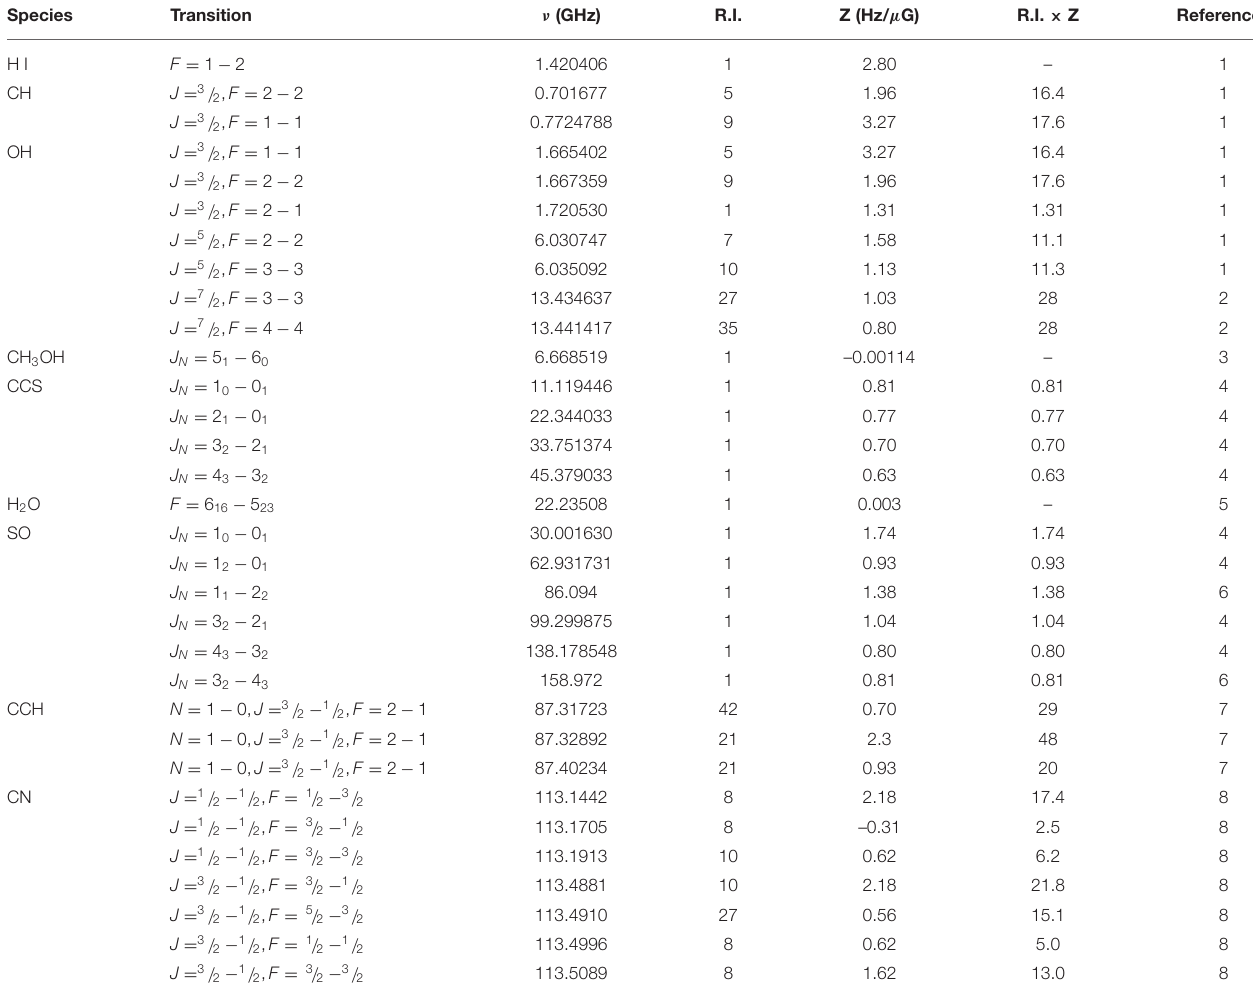
TABLE 1 | Zeeman splitting factors Z.